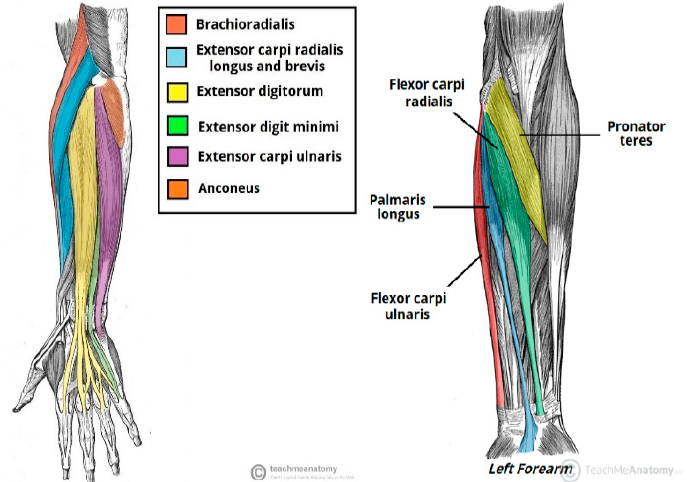
Figure 4. Muscles in the forearm (left) reproduced from